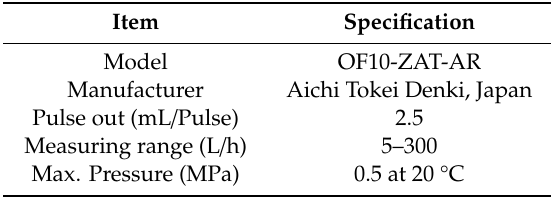
Table 2. Specifications of the flow meter used in this study.